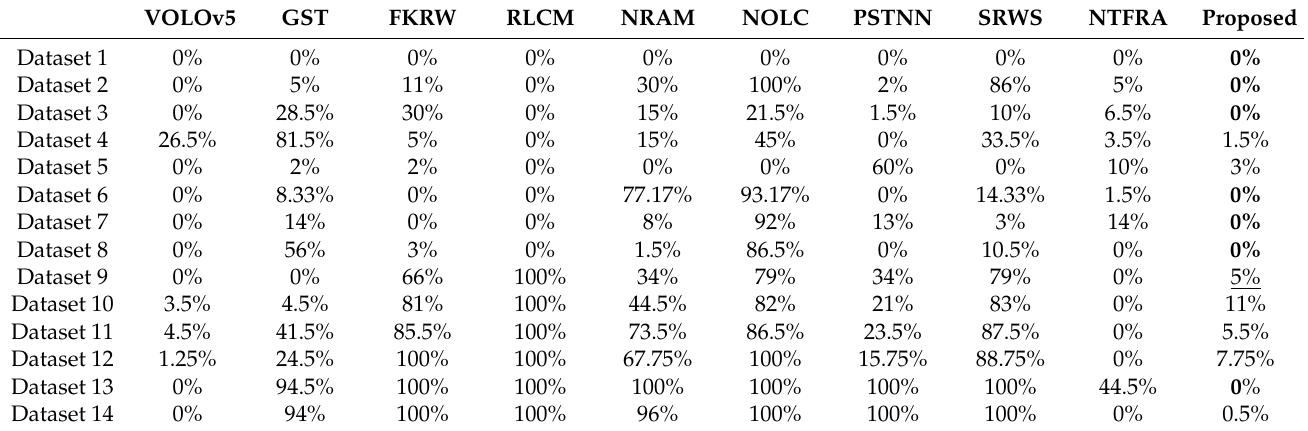
Table 5. Comparison of average MAR between the proposed method and 9 baseline methods in 14 sequence scenes.